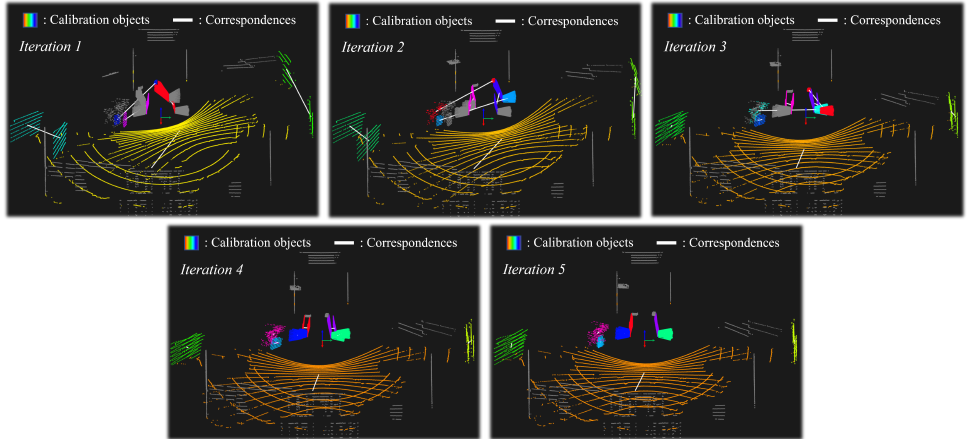
Figure 6. Process of plane registration in a challenging scenario where the initial modeling pose is significantly different from the ground truth. Each pair of corresponding planes is marked with the same color and connected by a white